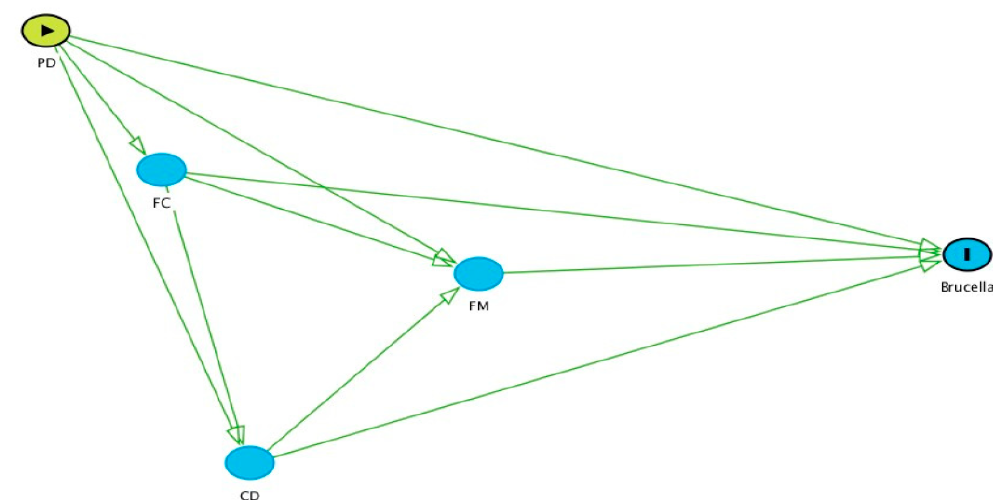
Figure 1. Causal diagram of potential risk factors with Brucella seropositivity. PD: producer demographics, FC: farm characteristics, CD: cattle demographics, FM: farm management. Here, arrows indicate the probability of causation of the outcome (Brucella seropositive) by different potential risk factors